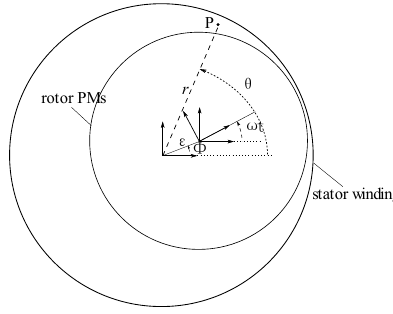
Figure 3. Frames and coordinates used for the model.